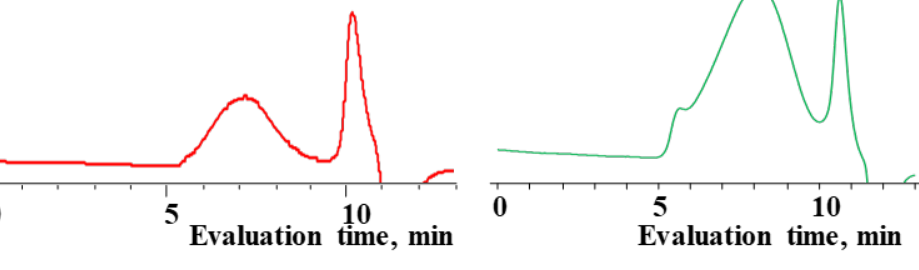
Figure 7. Characteristics of the initial mixture of / and the product of their co- polymerization (№ 1, Table 3): GPC data for the initial mixture (green curve) and the product (red curve); GLC curves of the initial mixture of monomers (top right) and volatile fraction after copoly- merization (bottom right); 1 H NMR spectrum (top left) and GPC curve (bottom left) of obtained copolymer.